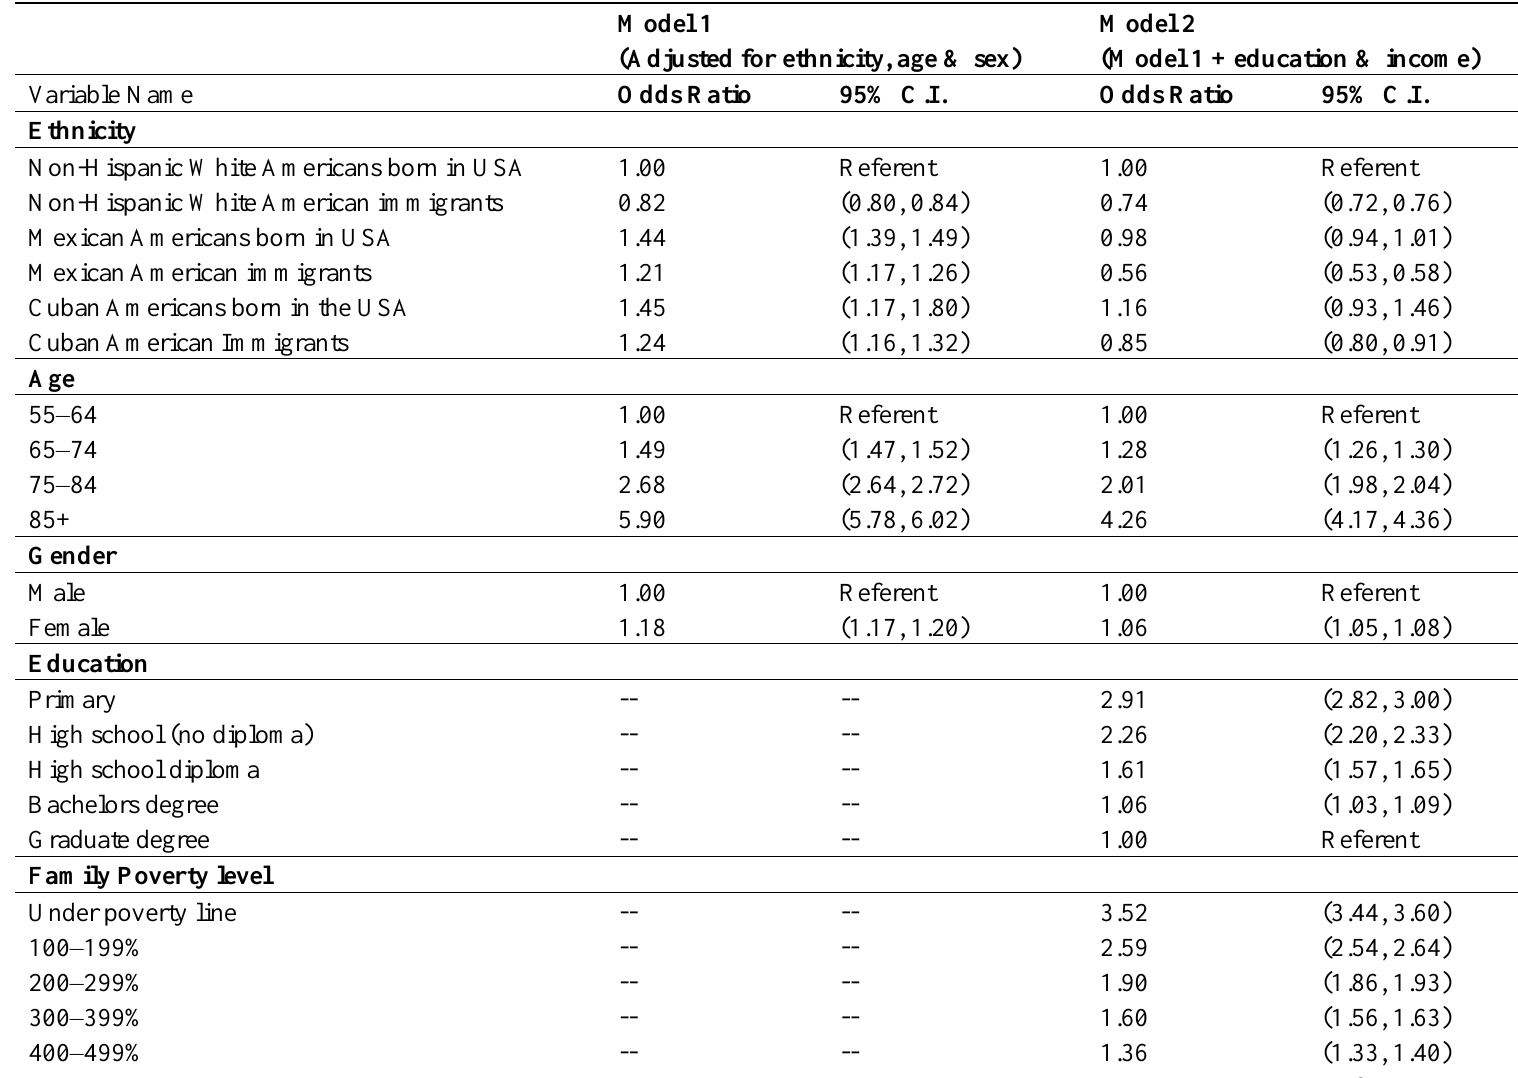
Table 3. Logistic regression analyses of functional limitations status by ethnicity and immigrant status for individuals aged 55 and